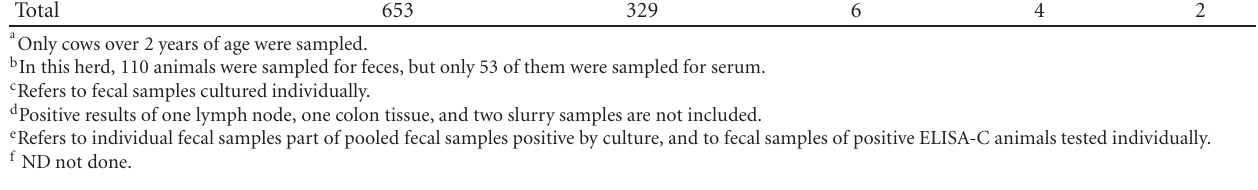
Table 3: Enzyme-linked immunosorbent assay (ELISA-C), poly- merase chain reaction (PCR), and culture results of animals and individual slurry samples from positive pooled samples or ELISA- C-positive animals of herd 1 and herd 2.